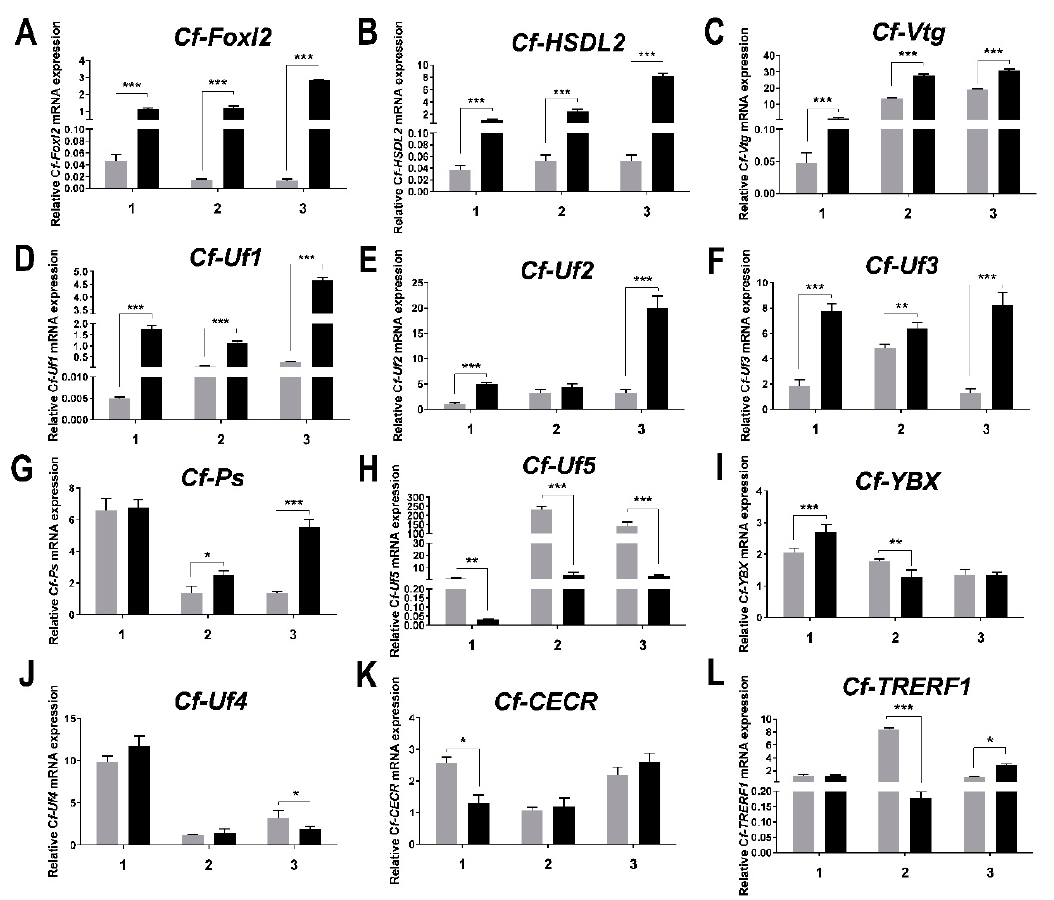
Figure 4. The mRNA expression levels of the candidate factors and Cf-Foxl2 in the gonads of C. farreri at different stages. Gray bars and black bars: the expression levels in testis and ovary, respectively. 1: proliferative stage, 2: growing stage, 3: mature stage. ( A – G ), ( I , J ): ovarian with the lowest expression were set to “1.00” to calibrate the relative expression; ( H , K , L ): testis with the lowest expression were set to “1.00”. Values are presented as the mean ± SD ( n = 3). * p < 0.05, ** p < 0.01, *** p < 0.001.